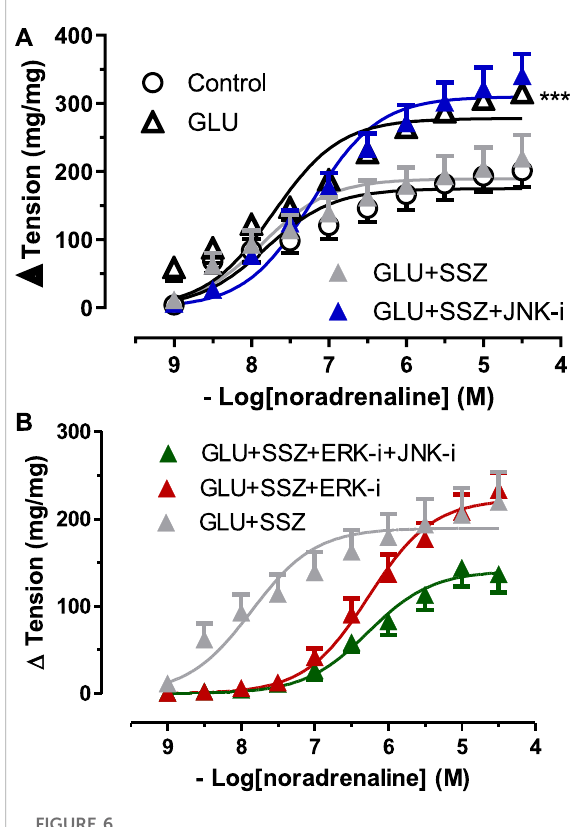
FIGURE 6 (A) Effect of JNK inhibitor on noradrenaline induce tension in rat aortic rings. Concentration-response curve for cumulatively increaseing concentrations of noradrenaline in the presence physiological glucose concentration (11.1 mM, Control), 44 mM glucose (GLU), 44 mM glucose and 300 mM sulfasalazine (GLU + SSZ), 44 mM glucose, 300 mM sulfasalazine and 10 µM JNK inhibitor SP600125 (GLU + SSZ + JNK-i). Symbols indicate mean values ±SEM, from 8, 7, 8 and 12 aortic rings (Control, GLU, GLU + SSZ, GLU + SSZ + JNK-i). *** p < 0.0001 for larger E max in GLU+SSZ+JNK-ivs.GLU+SSZ(F-test). (B) EffectofJNKandERK inhibitors on noradrenaline induce tension in rat aortic rings. Concentration-response curve for cumulatively increaseing concentrations of noradrenaline in the presence physiological glucose concentration (11.1 mM, control), 44 mM glucose (GLU), 44 mM glucose and 300 mM sulfasalazine (GLU + SSZ), 44 mM glucose, 300 mM sulfasalazine and 10 µM ERK inhibitor U0126 (GLU + SSZ + ERK-i), 44 mM glucose, 300 mM